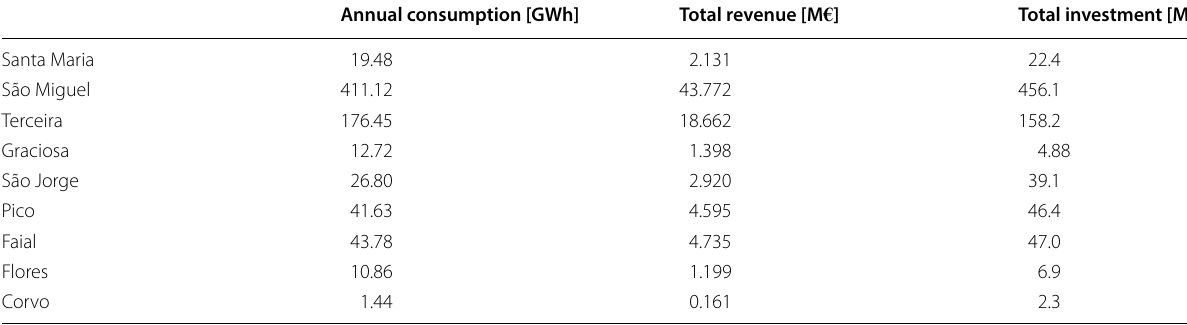
Table 20 Consumption and total cost of electricity in the Azores in 2018 Annual consumption [GWh] Total revenue [M € ] Total investment [M €